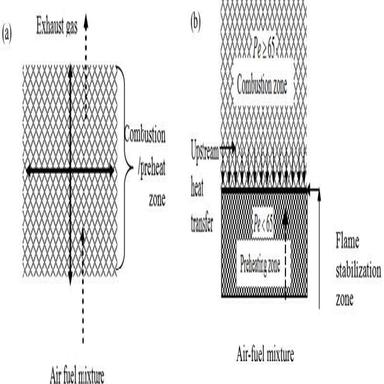
Schematic of (a) single layered (b) double layered PRB